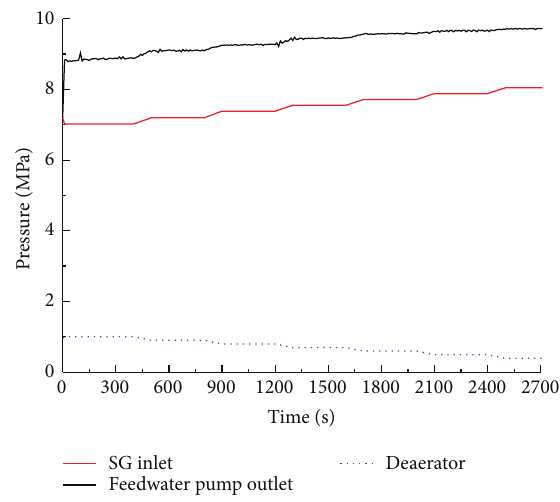
Figure 6: Transient change of pressure for SG inlet, deaerator, and feedwater pump